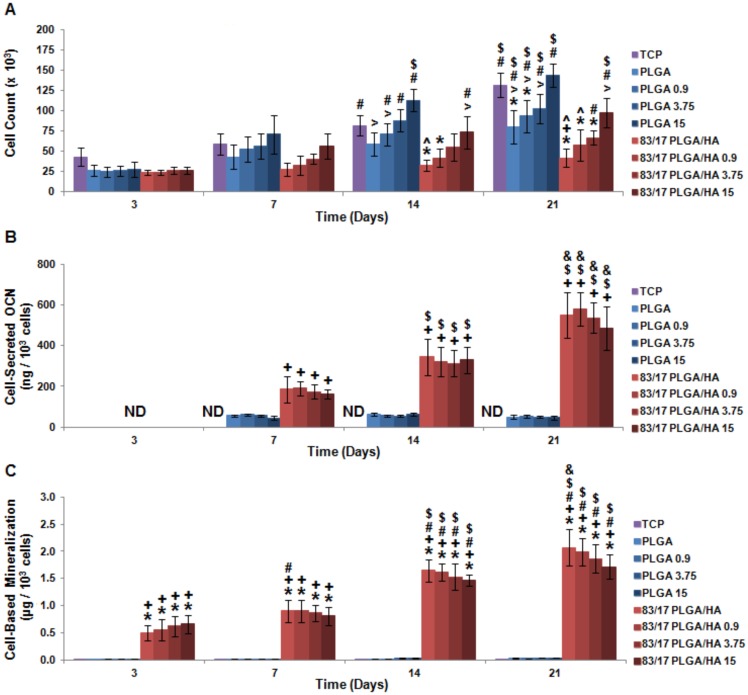

In vitro osteoinductivity of BMP-2 loaded PLGA/HA composite scaffolds.(A) MSC proliferation as measured by Quant-iT PicoGreen Assay. (B) Mineralization as assessed by alizarin red staining of deposited calcium. Cell-based mineralization was quantified by subtracting out scaffold-based mineralization and normalizing by cell count. (C) MSC OCN production induced by BMP-2 loaded PLGA/HA scaffolds. Cell-secreted OCN determined by ELISA and normalized by cell count. ND =  Not Detectable; N = 4; p<0.05 for + =  PLGA (same BMP-2 loading and same time point), $ =  Same Experimental Group (Day 7), and & =  Same Experimental Group (Day 14).